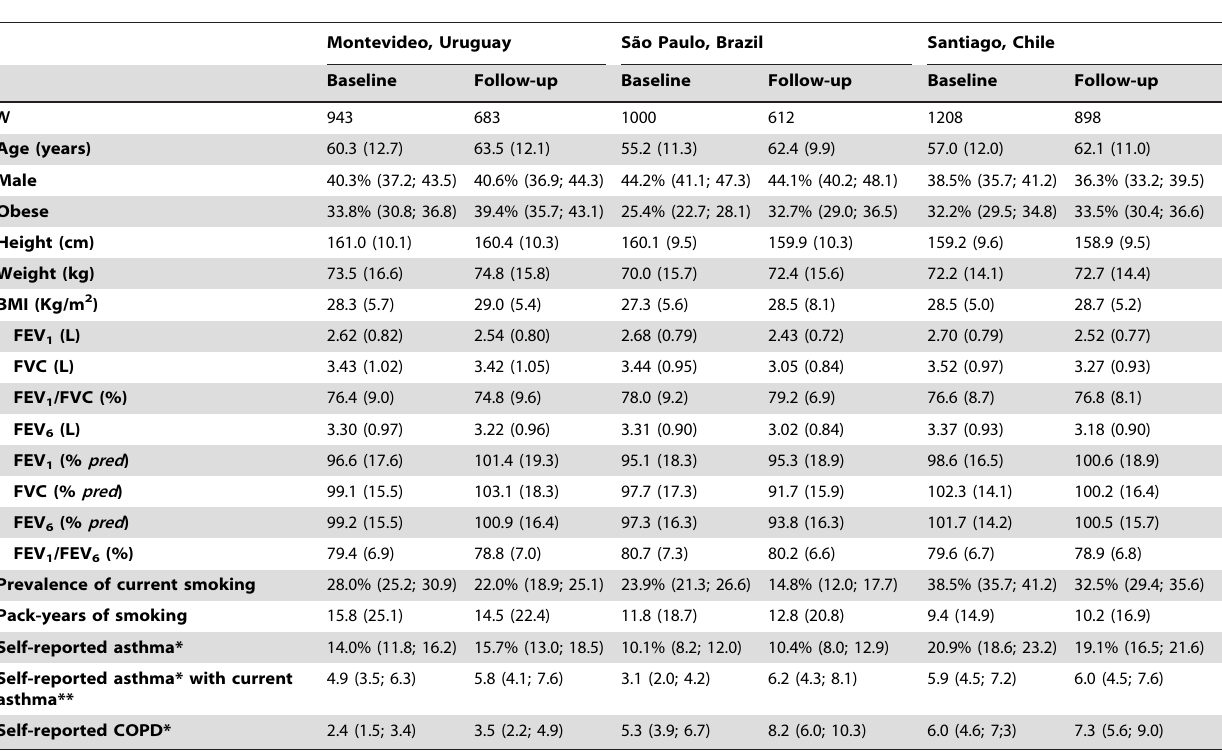
Table 1. PLATINO study participants’ characteristics and post-BD spirometry results by study center.